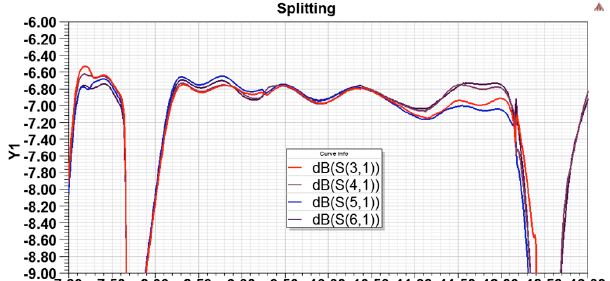
Figure 12: Balanced power splitting achieved by the Spatial Power Combiner fed by the TE mode